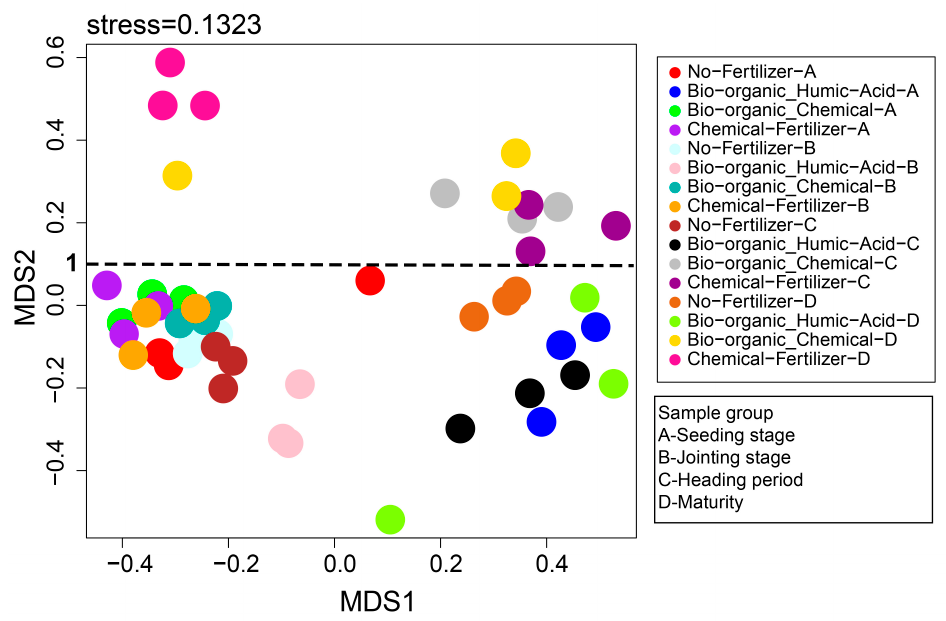
Figure 5. The nonmetric multidimensional scaling (NMDS) plot for soil fungal communities under different fertilization methods. Differently shaped and colored symbols correspond to different sampling dates and different fertilization methods, respectively. The fungal communities of the maize heading stage and maturity stage in bio-organic + chemical and chemical fertilizer treatments were separated from those in no fertilizer and bio-organic + humic acid treatment along the NMDS2 axis (dashed